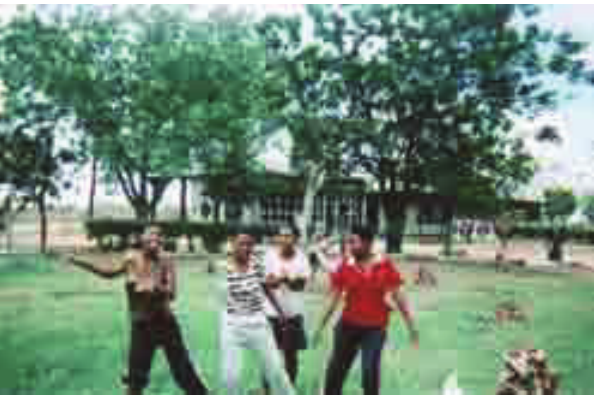
Figure 6: Drought’s friends singing ‘Morabaraba’ song